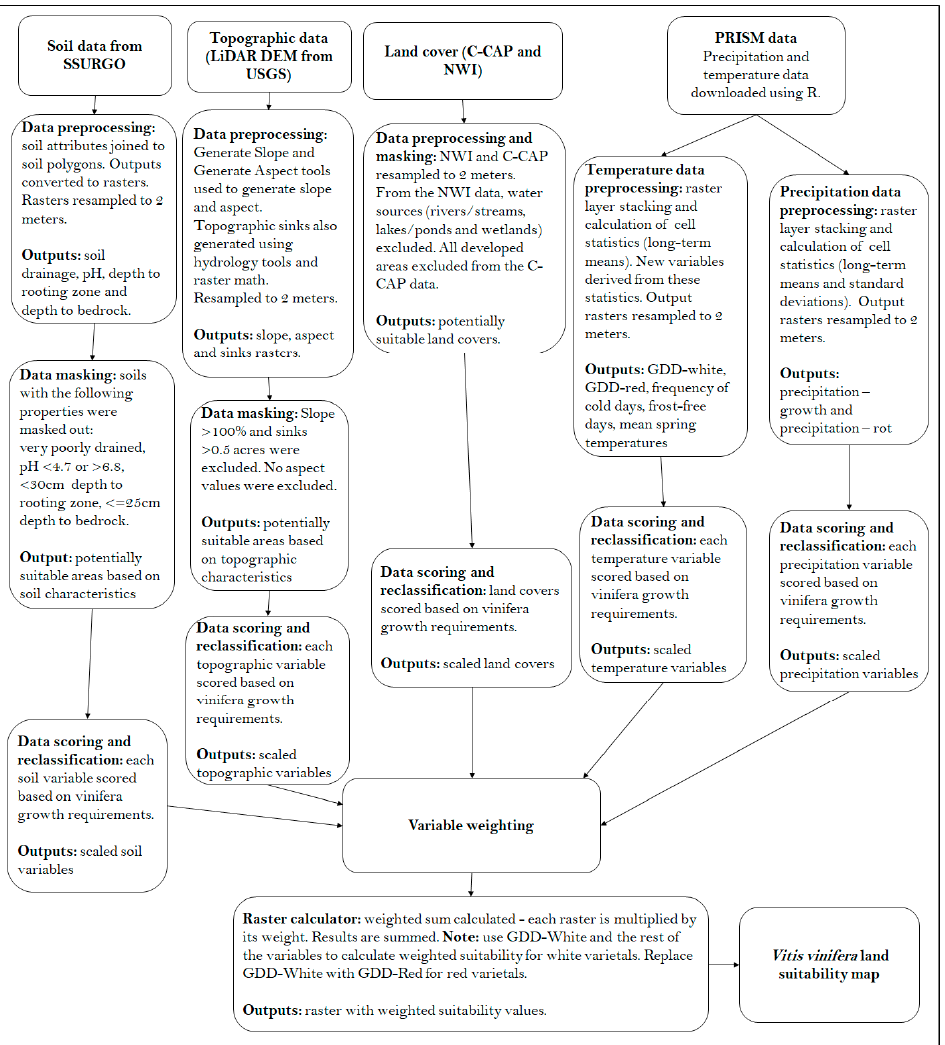
Figure 5. Flowchart of methods used in LSE model development and testing.